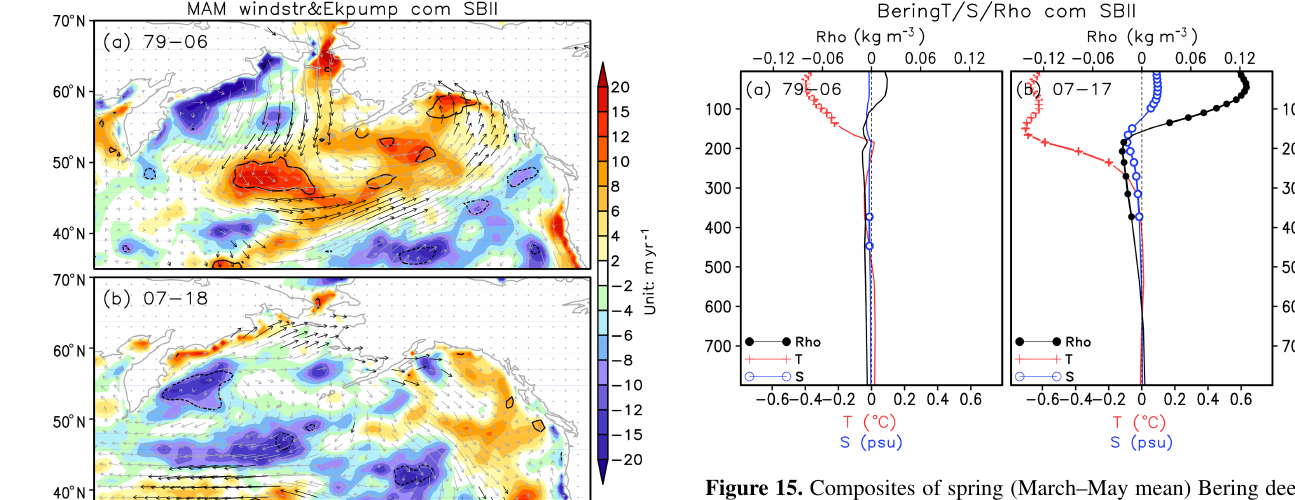
Figure 15. Composites of spring (March–May mean) Bering deep basin temperature, salinity and density based on the SBII high mi- nus low index during the 1979–2006 period (a) and the 2007–2017 period (b) for each depth layer. The black dots, red crosses and blue circles denote the regression coefficients that are significant at the 85% significant t test for density, temperature and salinity, respec-